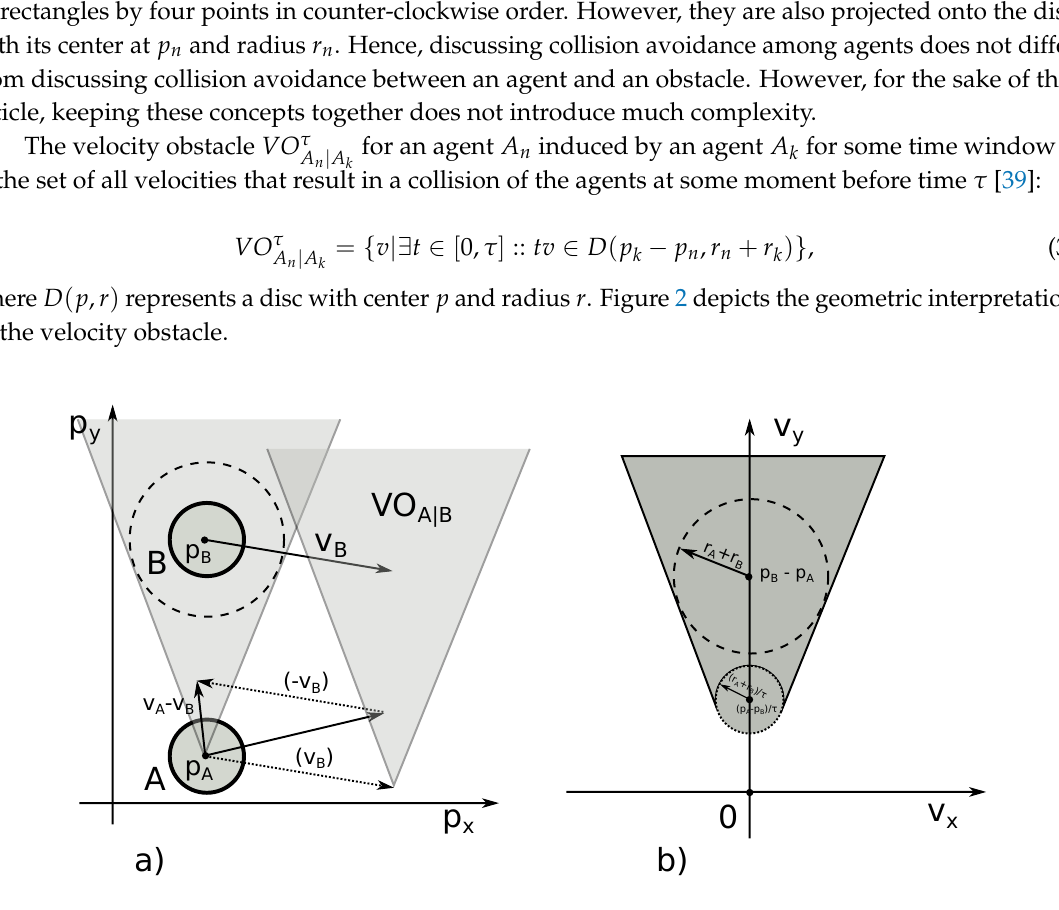
Figure 2. The geometric interpretation of the velocity obstacle. ( a ) general idea; ( b ) limitation induced by τ